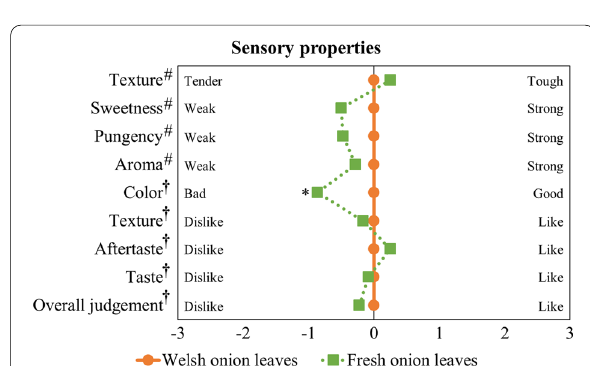
Fig. 3 Comparison of sensory properties in leaves of Welsh onion and fresh onion. # Intensity, † preference. Values are expressed as fold change relative to Welsh onion leaves each evaluation (Welsh onion leaves 0). Values are the means ( n 36). * p < 0.05 (Scheffe’s method = = of paired comparison), the scores for each evaluation for fresh onion leaves were evaluated when the Welsh onion leaves were considered to be